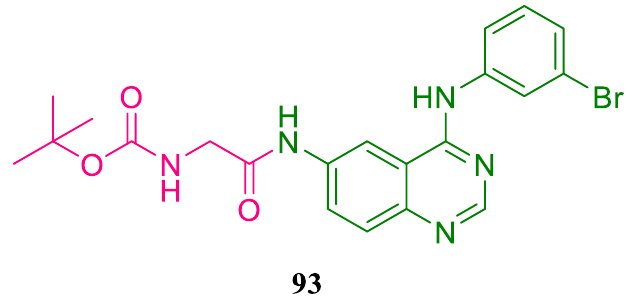
Figure 75. 4-anilinoquinazoline-amino acid